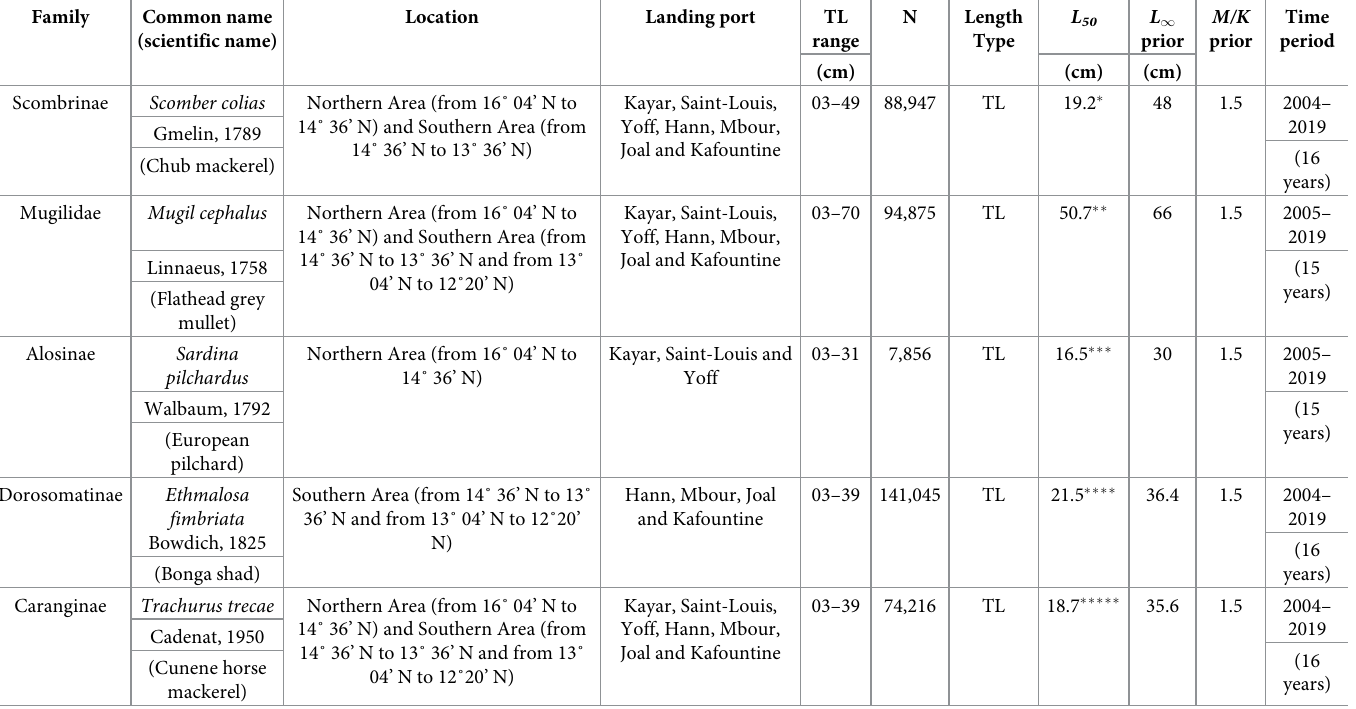
Table 1. Basic information for the five studied fish